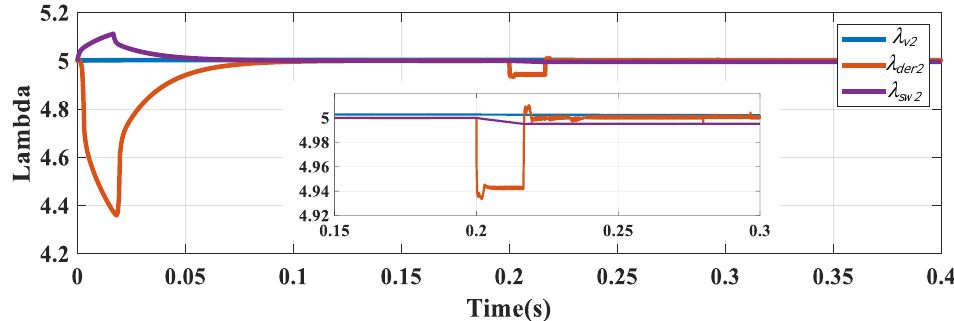
Figure 16. Study 2: generated weighting coefficients for FCS-MPC in